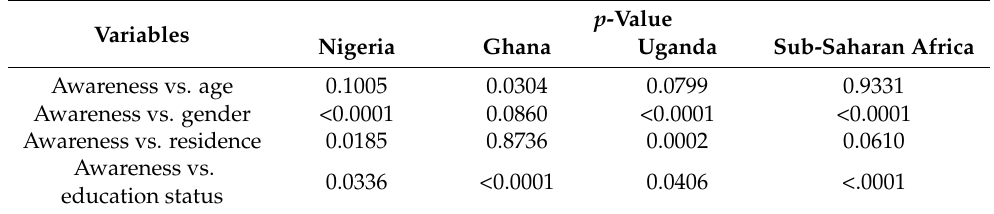
Table 2. Association between public awareness of the malaria vaccine and demographic characteristics. p -Value Variables Nigeria Ghana Uganda Sub-Saharan Africa Awareness vs. age